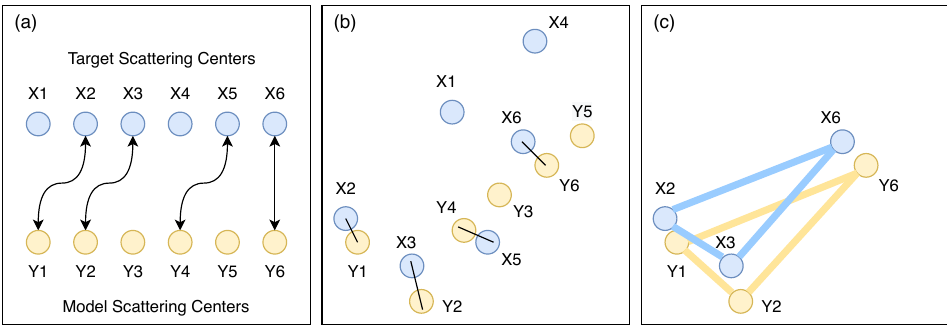
Figure 2. ( a ) Hungarian Algorithm scattering centers assignment, ( b ) global similarity and ( c ) local similarity. Shan et al. [49] used morphological opening and closing operations to create Dominant Scattering Areas (DSA) in the original image. Subtracting the DSA of the test image from those of different classes of models resulted in the residues representing the differences between the test image and the classes. An example is presented in Figure 3.